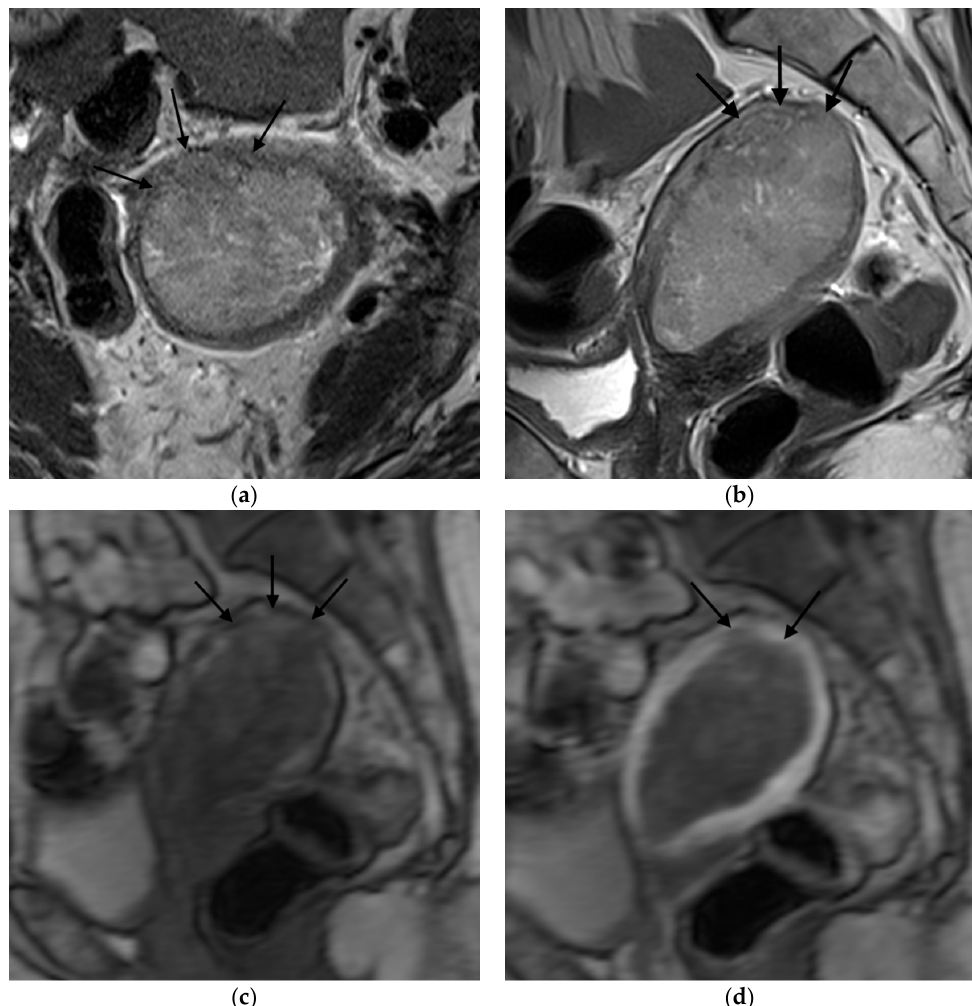
Figure 2. Representative MRI images of endometrial carcinoma with ≥ 50% myometrial invasion. ( a ) Axial T2WI, ( b ) sagittal T2WI, and ( c , d ) sagittal DCE-MRI images during the early ( c ) and late ( d ) acquisition stages. Tumors (arrow) with ≥ 50% myometrial invasion presented as iso- to mildly hyperintense on T2WI compared to the myometrium ( a , b ) with disruption of the junctional zone. On DCE-MRI, the tumors appeared as hypointense masses compared to the adjacent myometrium with interrupted subendometrial enhancement (SEE) ( c ), irregular tumor-to-myometrium interface, and extension of the tumor beyond the outer half of the myometrium ( d ). Abbreviations: MRI, magnetic resonance imaging; dynamic contrast-enhanced magnetic resonance imaging (DCE-MRI); T2WI, T2-weighted imaging; subendometrial enhancement (SEE).